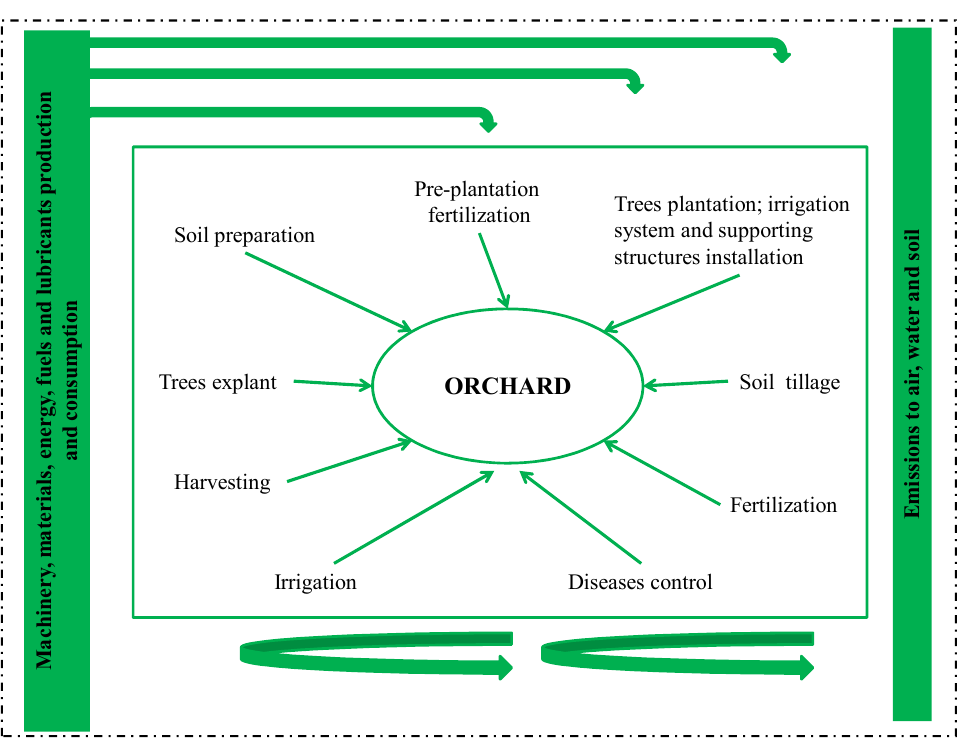
Figure 1. System boundaries for Life Cycle Assessment (LCA), Carbon Footprint (CF) and Energy Analysis (EA).